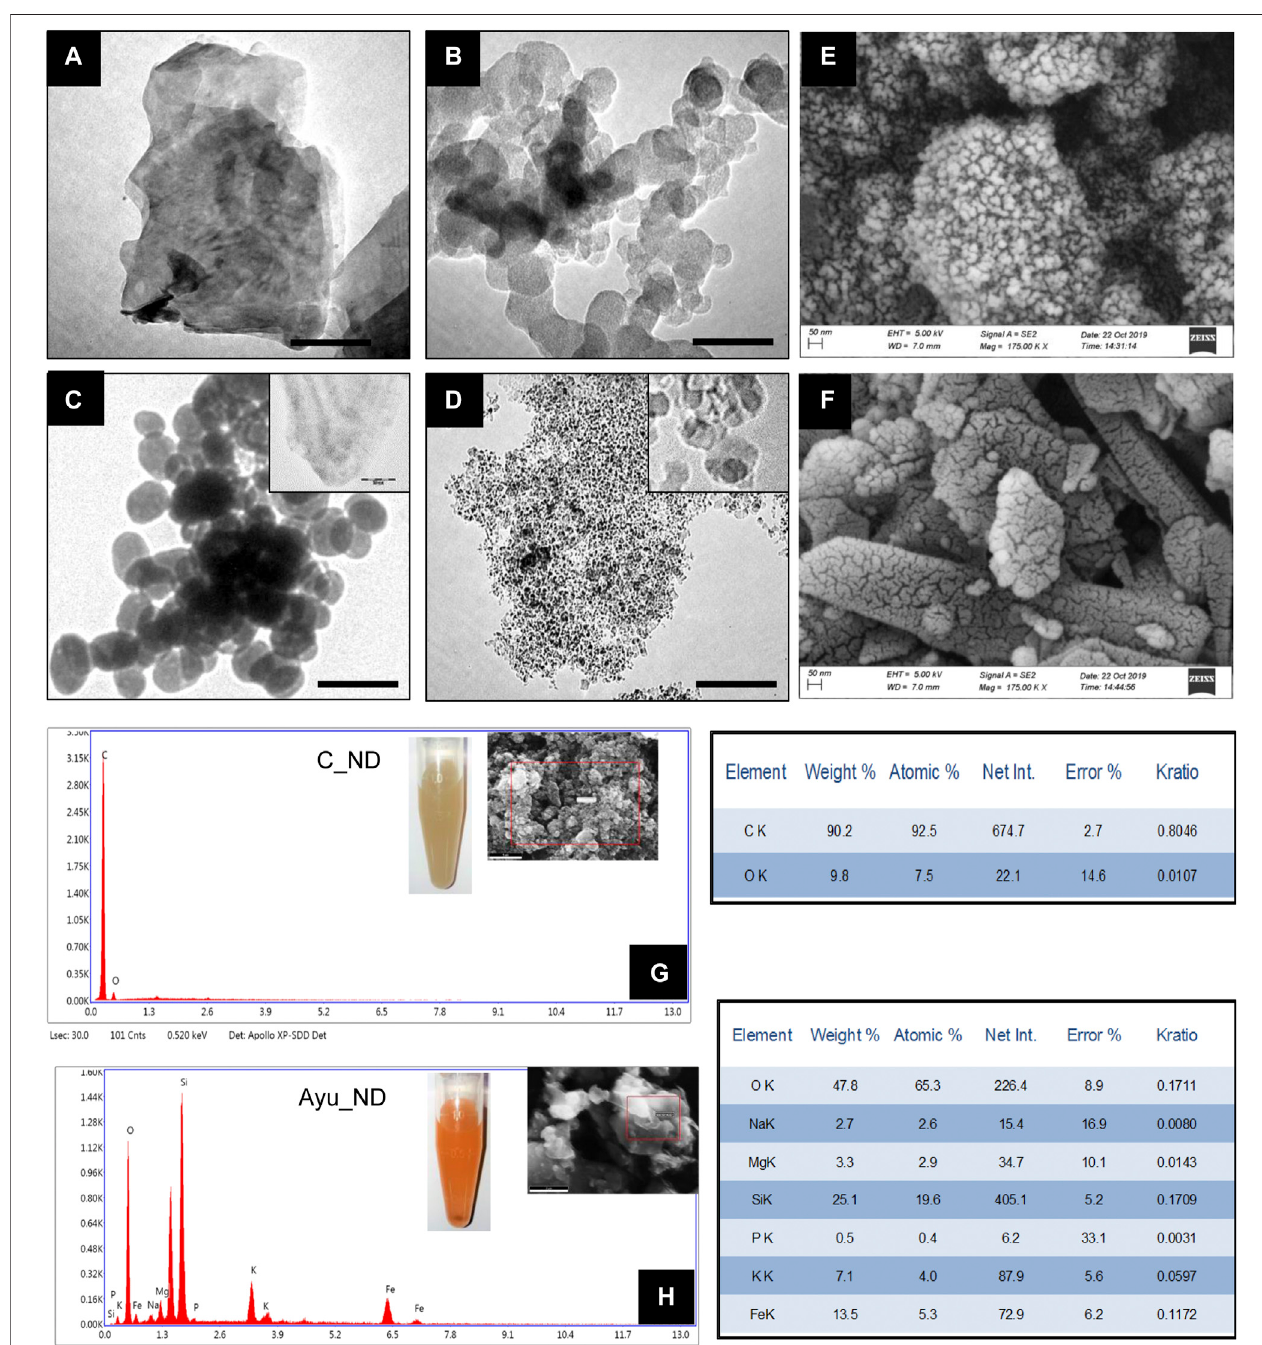
FIGURE 1 | Characterization of as-prepared Ayu_ND. TEM images of the diamond powder (A) , diamond ash (B) , Heeraka Bhasma or Ayu_ND (C) , and commercialnanodiamondorC_ND (D) .TheScalebaris50.0 nm.FESEMimagesofAyu_ND (E) andC_ND (F) .Elementalanalysis(EDAX),includingtheimages(inset)of C_ND (G) and Ayu_ND (H) in aqueous solution. Representative images and plot of three independent experiments.